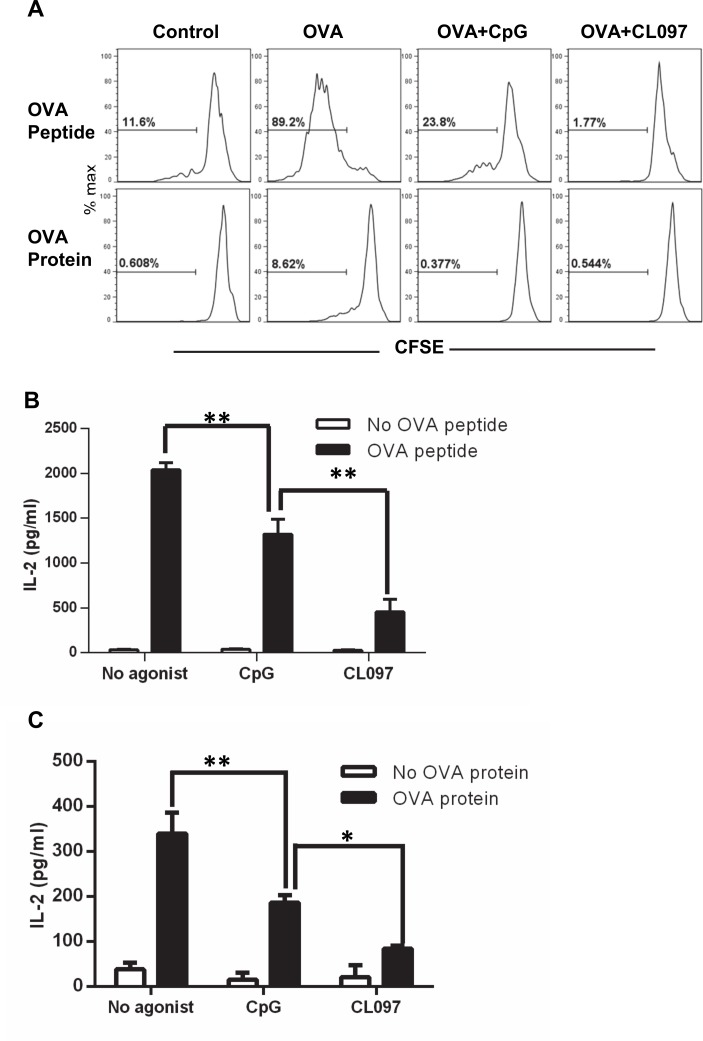
Stimulation of DCs with CpG and CL097 suppresses OT-II CD4+ T cell proliferation and IL-2 production.OT-II CD4+ T cell/DC co-cultures stimulated with TLR ligands and OVA peptides were harvested to assess CD4+ T cell proliferation (A) and IL-2 production (B and C). (A) OT-II CD4+ T cells stained with CFSE were co-cultured with DCs and stimulated with OVA peptide (0.1 μM) or OVA protein (25 μg/ml) in the presence or absence of CpG or CL097 (1 μg/ml) for four days until analyzed by flow cytometry. The range and number in each histogram represent cells that proliferated at least one time. Supernatants from cultures stimulated with OVA peptide (B) or OVA protein (C) in the presence or absence of CpG (1 μg/ml) or CL097 (1 μg/ml) for four days were harvested to measure IL-2 levels by ELISA. Statistical differences between treatments in OVA stimulated cells were analyzed by one-way ANOVA. Data are expressed as mean ± SD of triplicate wells. Data shown are representative of three independent experiments. *p<0.05; **p<0.005.